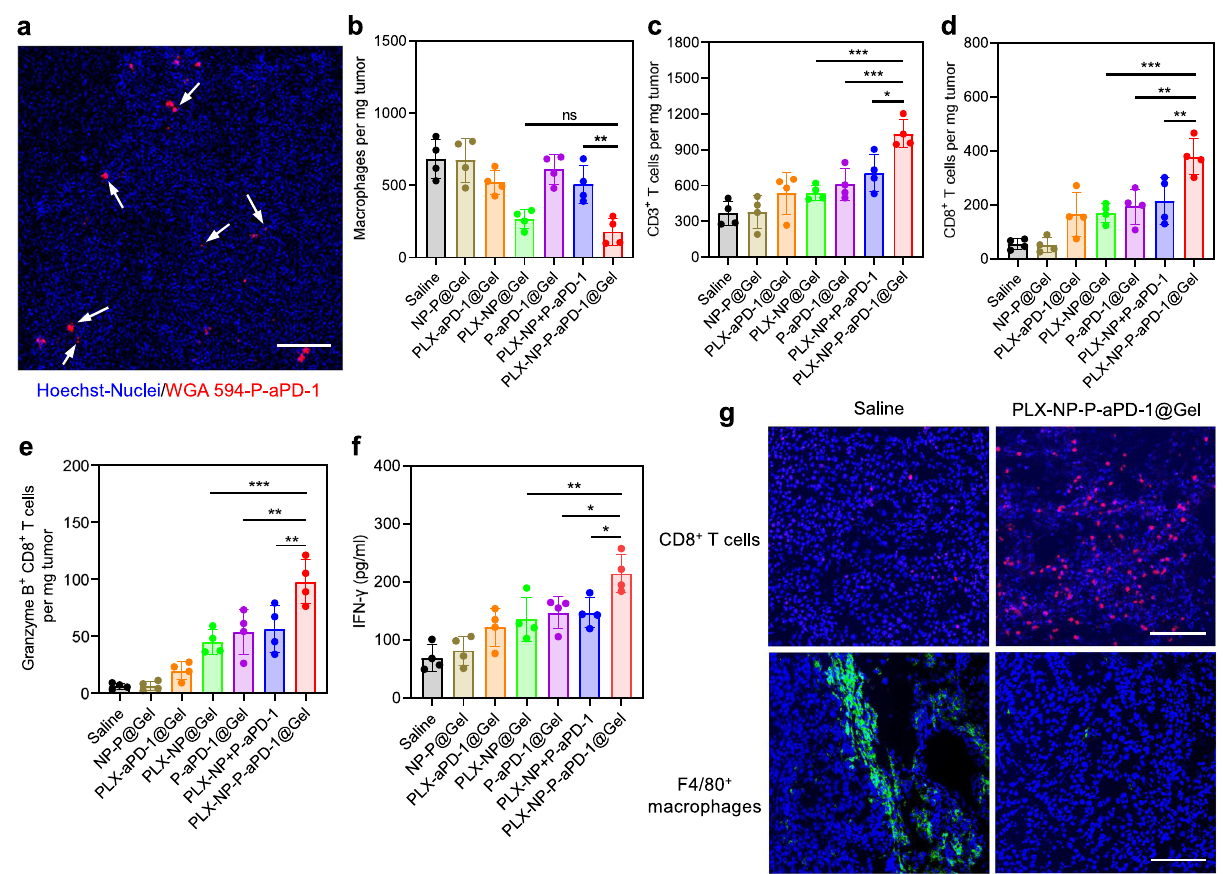
Fig. 4 Evaluation of in vivo immune response of PLX-NP-P-aPD-1@Gel in B16F10 tumor recurrence model. a Representative confocal microscopy images of platelets and the formation of platelet-derived microparticles at the tumor site ( n = 3 biologically independent samples). Scale bar, 100 µ m. b – e Quantitative analysis of the number of F4/80 + macrophages ( b , PLX-NP-P-aPD-1@Gel vs. PLX-NP@Gel: ns P = 0.7842; PLX-NP-P-aPD-1@Gel vs. PLX- NP + P-aPD-1: ** P = 0.0026), CD3 + T cells ( c , PLX-NP-P-aPD-1@Gel vs. PLX-NP@Gel: *** P = 0.0002; PLX-NP-P-aPD-1@Gel vs. P-aPD-1@Gel: *** P = 0.0009; PLX-NP-P-aPD-1@Gel vs. PLX-NP + P-aPD-1: * P = 0.0100), CD8 + T cells ( d , PLX-NP-P-aPD-1@Gel vs. PLX-NP@Gel: *** P = 0.0004;